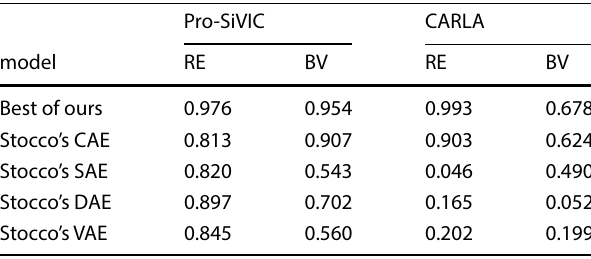
Table 10 AUROC scores calculated on Pro-SiVIC and CARLA data- sets with the best autoencoder models from our experiments and four Stocco’s autoencoders